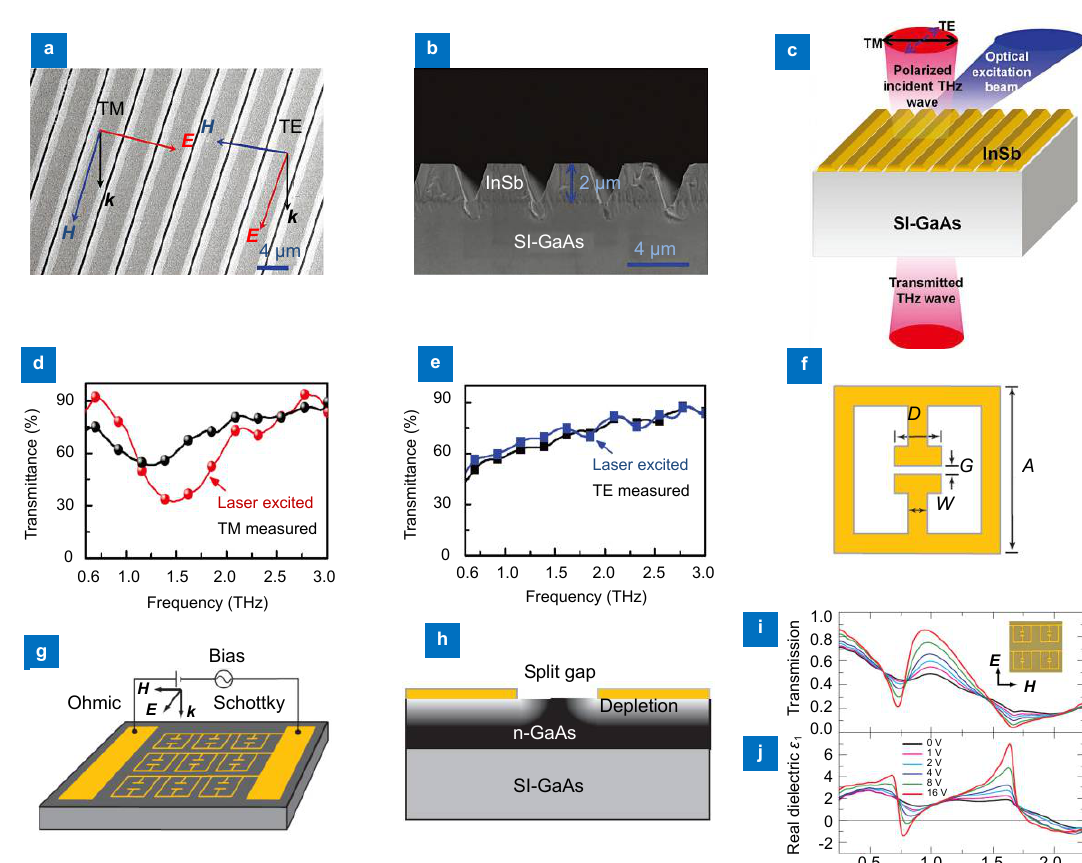
Fig. 13 | Tunable metamaterials using semiconductors as the active material . ( a ) Top and ( b ) side view SEM images of the fabricated InSb grating and ( c ) Schematic of the transmission measurement configuration used in FTIR. Measured transmittances of ( d ) TM and ( e ) TE polarized THz waves through samples with and without laser excitations. ( f ) Geometry and dimensions of the THz metamaterial resonator ( A= 36 μ m, G= 2 μ m, D= 10 μ m, and W= 4 μ m). ( g ) The metamaterial unit cells are connected together with metal wires to serve as a metallic (Schottky) gate. ( h ) The strength of the resonance is controlled by tuning the substrate charge carrier density near the split gaps which is relative to the voltage bias applied between the Schottky and ohmic contacts (the grey scale indicates the free charge carrier density). ( i ) Measured transmitted intensity of THz radiation, and ( j ) the corresponding permittivity for various gate voltage bias. Figure reproduced from: ( a – e ) ref. 58 , Licensed Content Publisher; ( f – j ) ref. 107 , Springer FTIR reflection spectra for an array of resonators on PDMS with a coupling distance of 60 nm are shown in Fig. 14(a). The as-fabricated resonator array had a reson- ance frequency of 5.78 μm (blue) and it shifted to 6.27 μm (dark red) after 25% stretching parallel to the SRR arms. The red line indicates the response of the array after functionalizing with coated p-mercaptoaniline (pMA). The dotted line shows the cross-polarized measurement for the functionalized array 230 . As shown in Figs. 14(b) and 14(c), polyethylene naphthalate (PEN) is also used to design a variable three-dimensional terahertz metama- terial to achieve resonance tunability 72 . Figure 14(d) shows that the resonance frequency of the metamaterial is decreased as the diameter of the tube folded from the